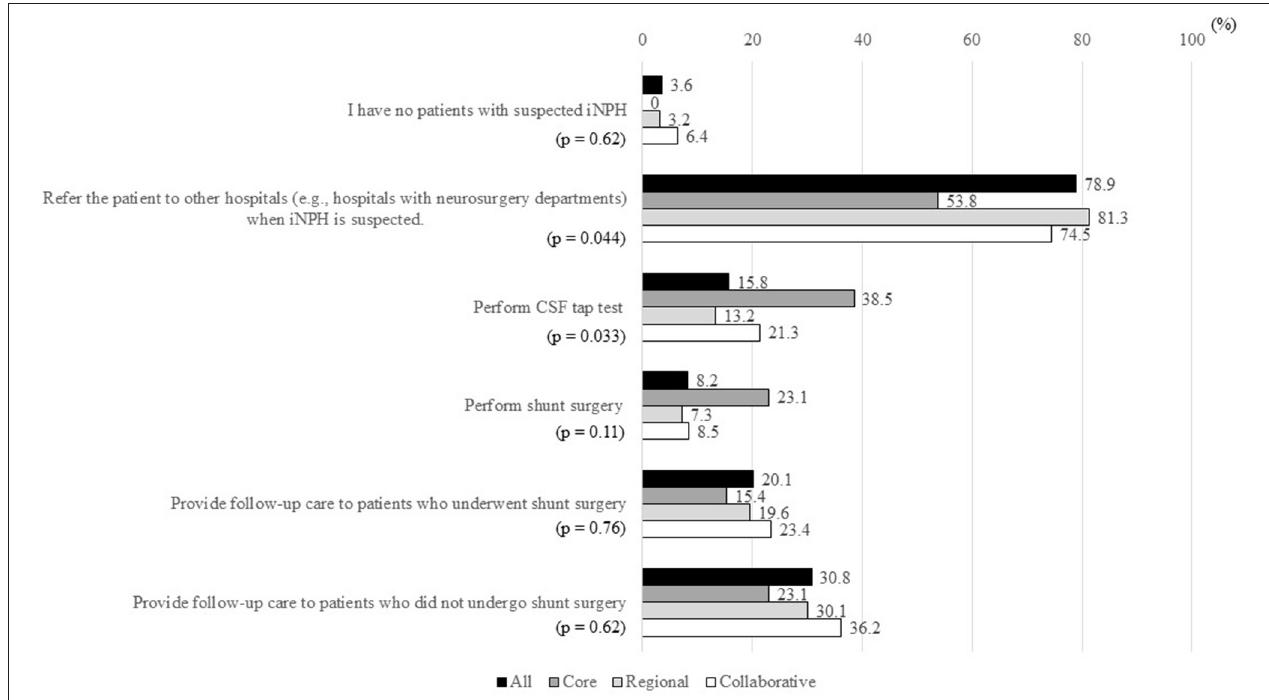
FIGURE 2 | Percentages of MCDs that answered “Yes” to items in response to the question “How do you evaluate and treat patients with suspected iNPH?”. MCD, medical center for dementia; iNPH, idiopathic normal-pressure hydrocephalus; CSF, cerebrospinal fluid. *The ratio of “Yes” answers were compared between the three types of MCDs using Fisher’s exact